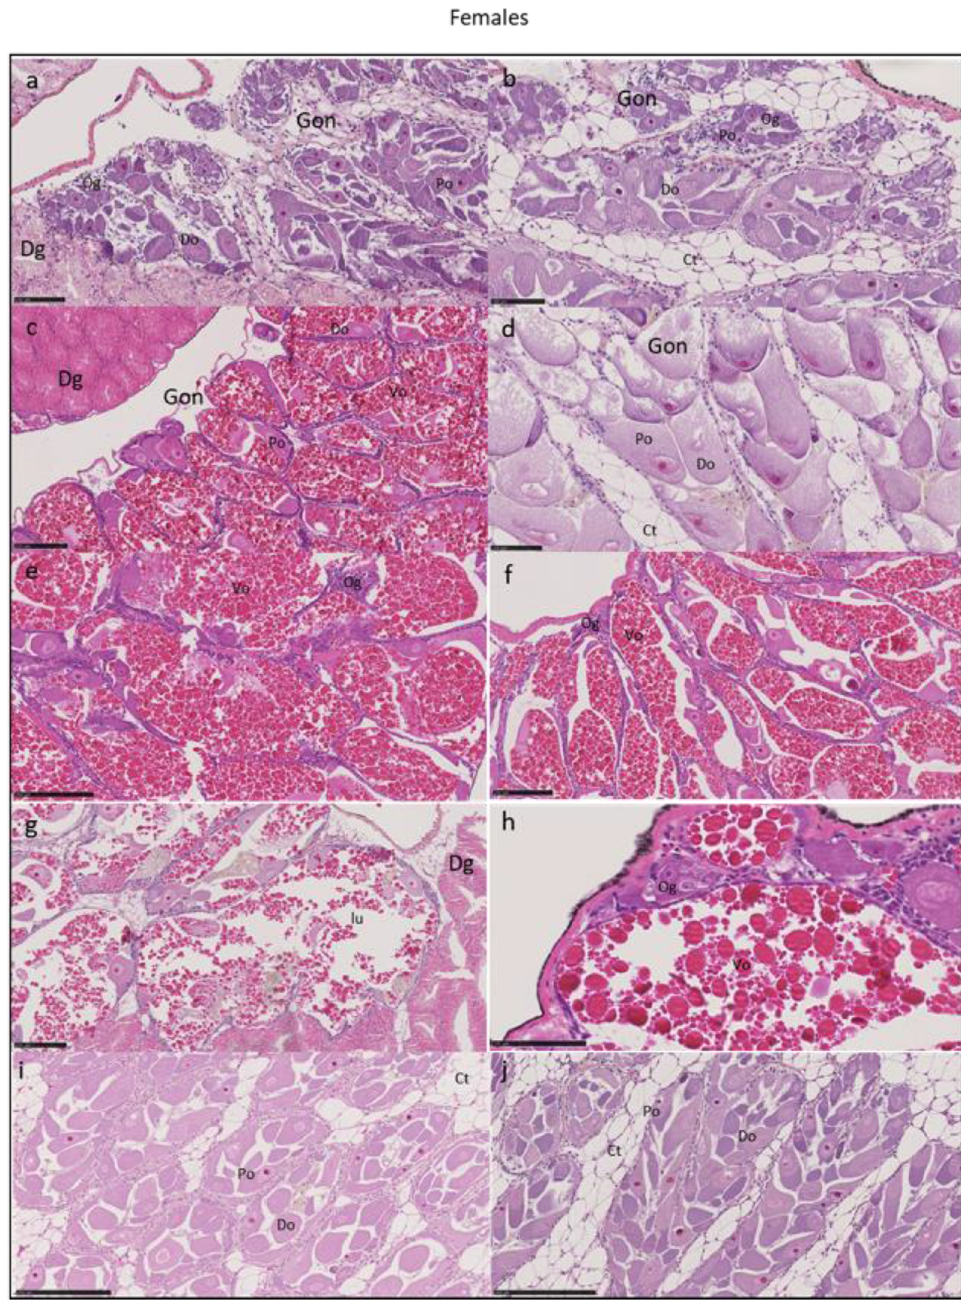
Fig. 5. T. mutabilis . Histological sections of the gonads of females larger than 20mm SH. (a 20.5 mm SH, b and c 24 mm, d 25mm, e 26.7mm, f 28.2mm, g 28.9mm, h 29.4 mm, i 31mm, j 33.5mm.) Ct connective tissue, Dg Digestive gland, Do Developing oocite, Gon Gonade, lu lumen; Og Oogonia, Po pre-vitellogenic oocite, Vo vitellogenic oocite. Scale bars= 100 m m (a, b, d, h); 250 m m (c, e, f, g, i,